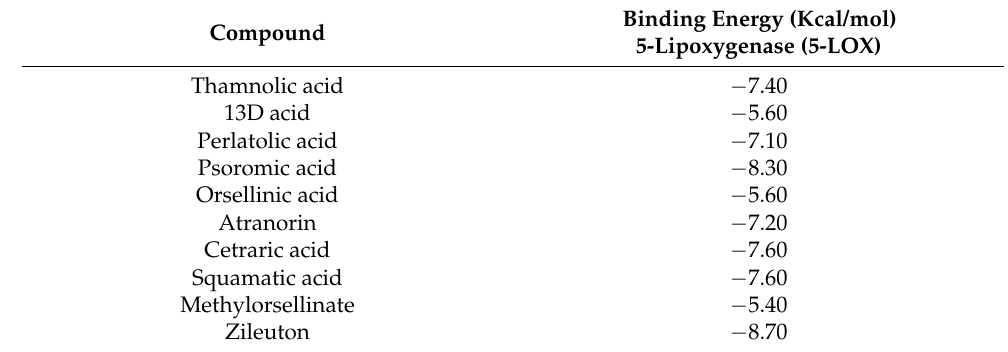
Table 6. Binding energies resulting from molecular docking experiments of the selected compounds in the extracts of Cladonia , together with the standard inhibitor zileuton on 5-lipoxygenase